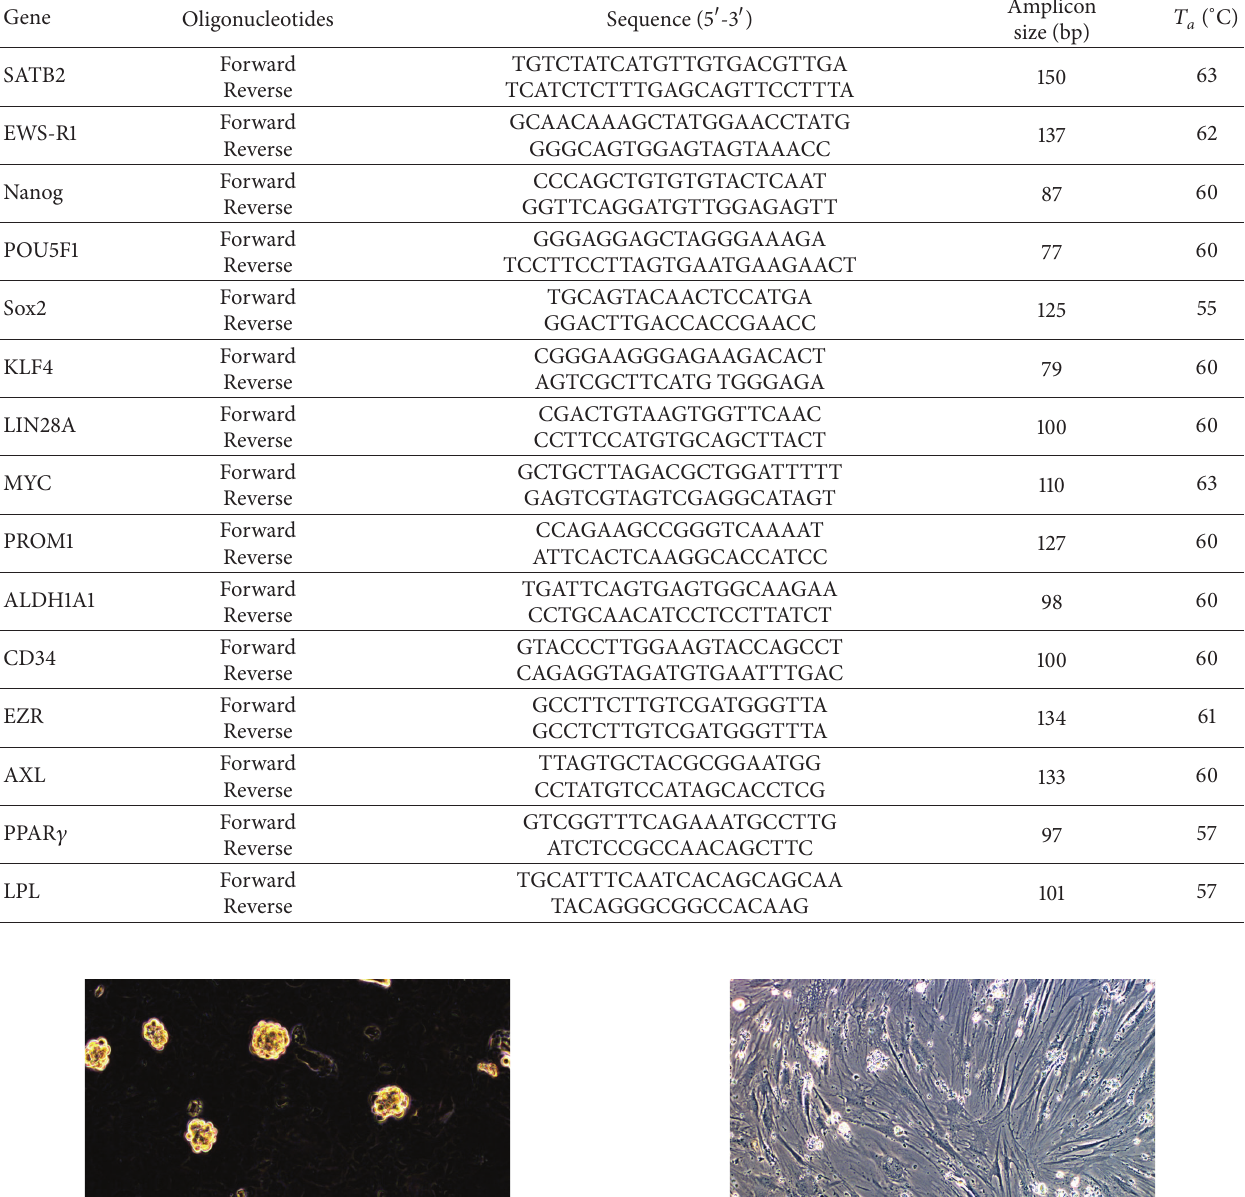
Table 1: Detailed list of primer sequences, with the amplicon size and annealing temperature.